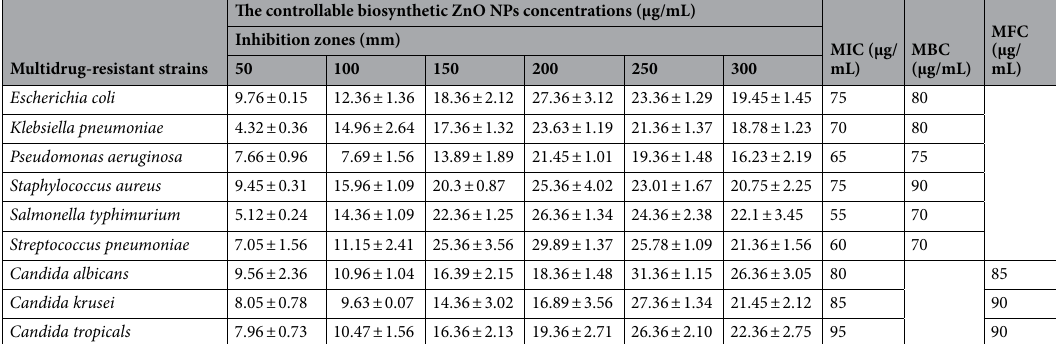
Multidrug-resistant